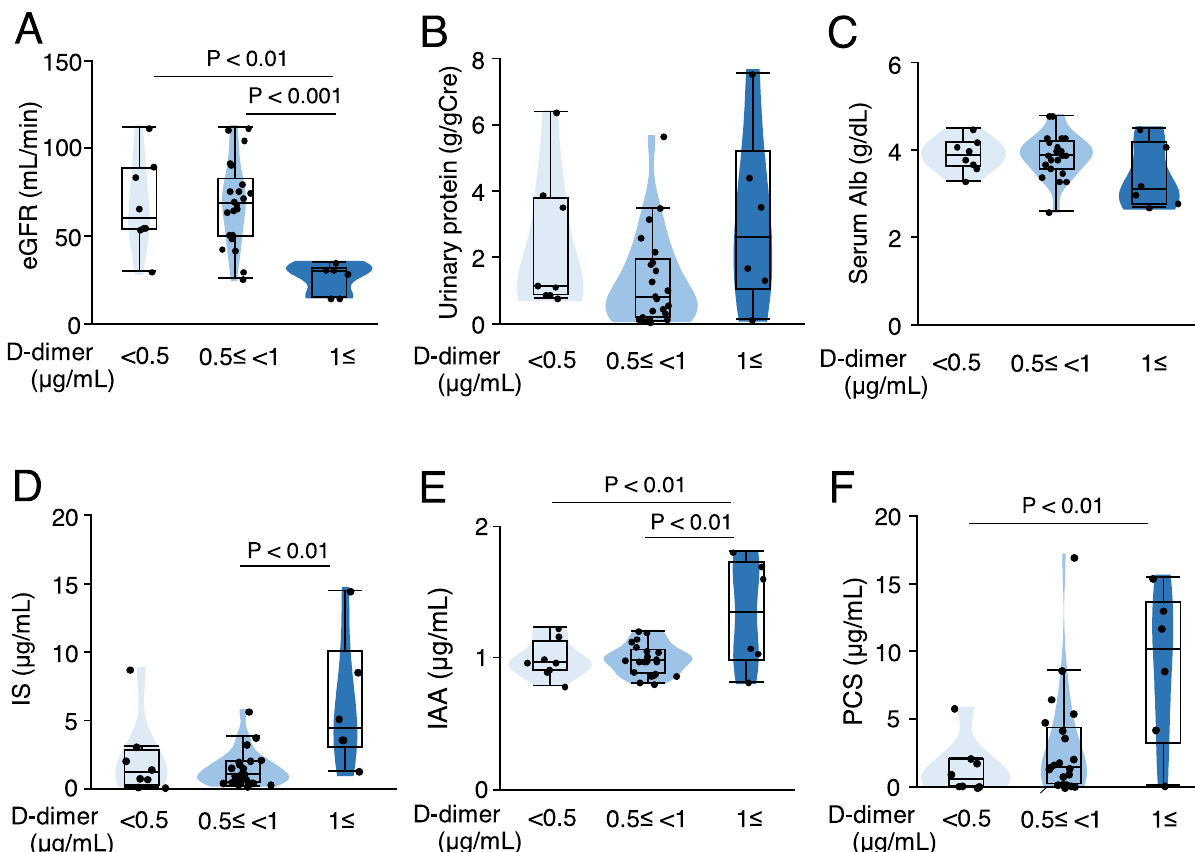
Figure 1. Association between plasma D-dimer and uremic toxin levels in CKD patients. Association between plasma D-dimer levels and ( A ) estimated glomerular filtration rate (eGFR), ( B ) urinary protein levels, ( C ) serum albumin (Alb) levels, ( D ) indoxyl sulfate (IS) levels, ( E ) indole-3-acetic acid (IAA) levels, and ( F ) p-cresyl sulfate (PCS) levels. gCre, g creatinine. n = 6–22. Data are shown as medians with interquartile